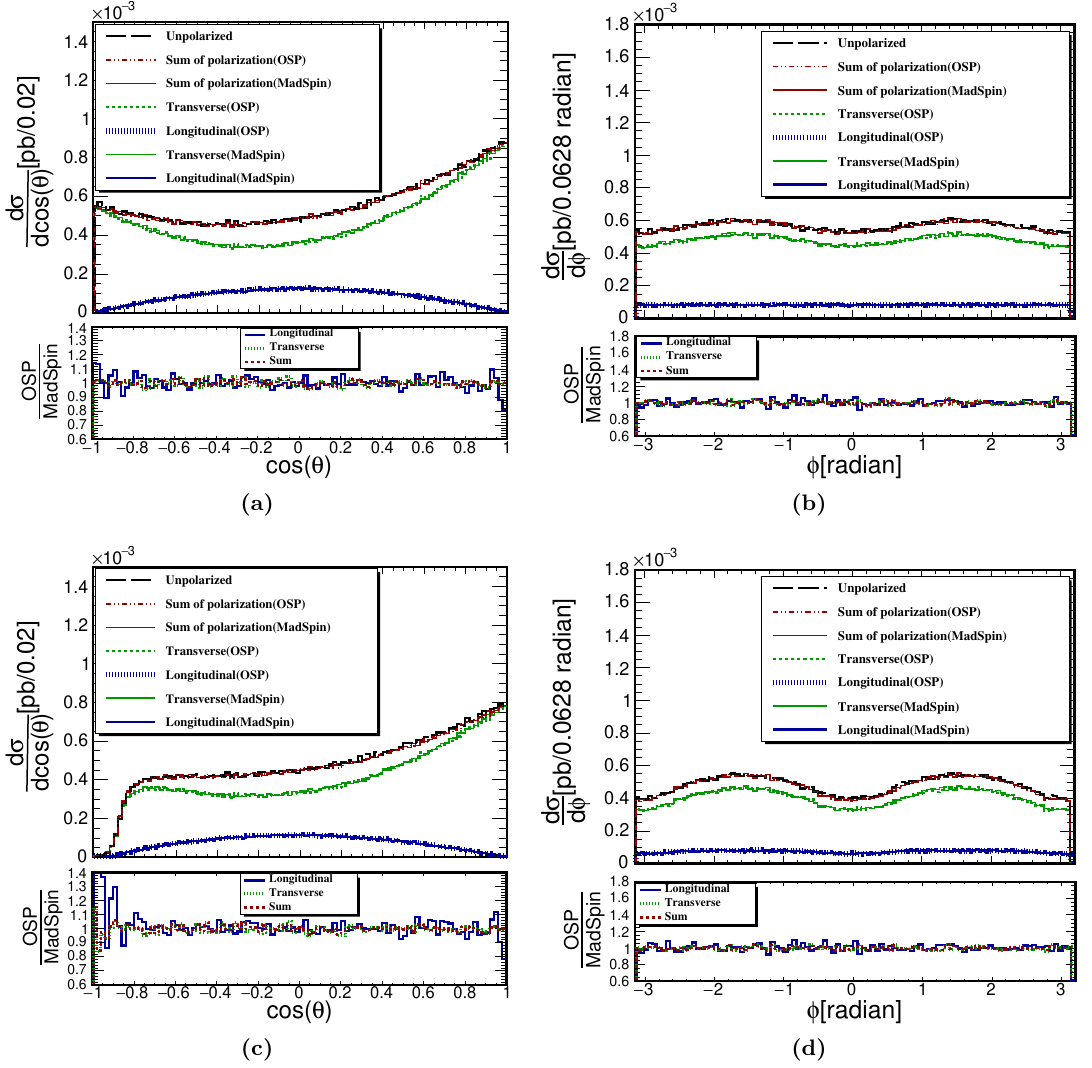
Figure 7. Same as (cid:12)gure 2 but for the mixed EW-QCD process pp ! jjW + W (cid:0)